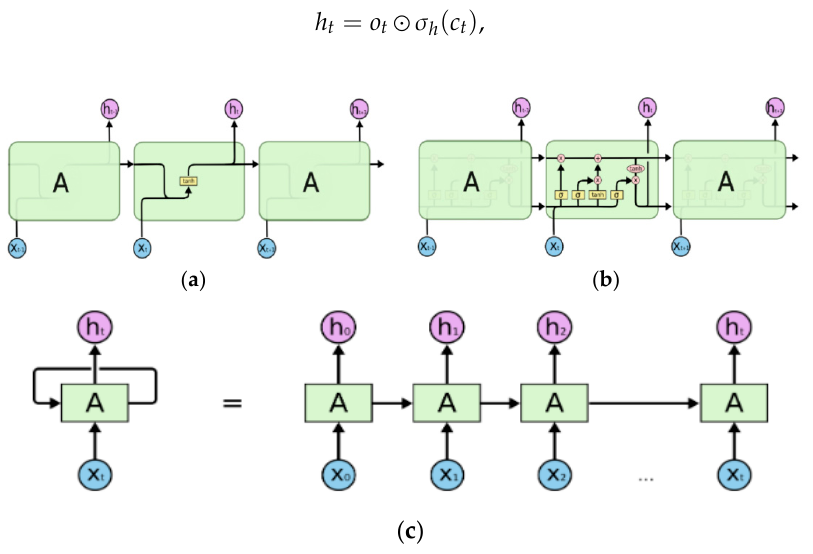
Figure 4. ( a ) The simple recurrent neural network (RNN) architecture, ( b ) the attention-based long short-term memory (A-LSTM) architecture, ( c ) the unrolled chain-type RNN structure.